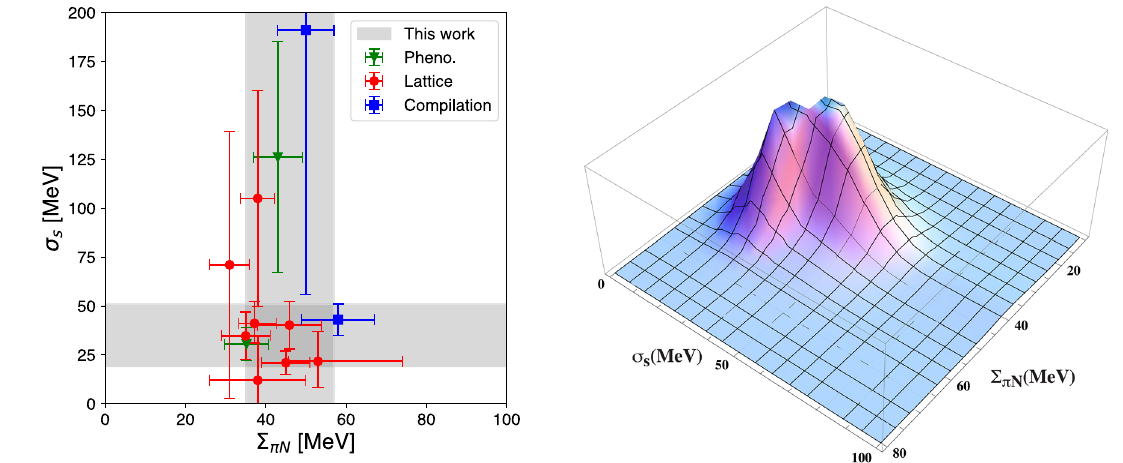
Fig. 5 Scatter plot of ((cid:7) π N ,σ s ) , with grey bands showing the ranges of (cid:7) π N and σ s that we estimate on the basis of our new compilation. Right panel: Two-dimensional ideogram of (cid:7) π N and σ s